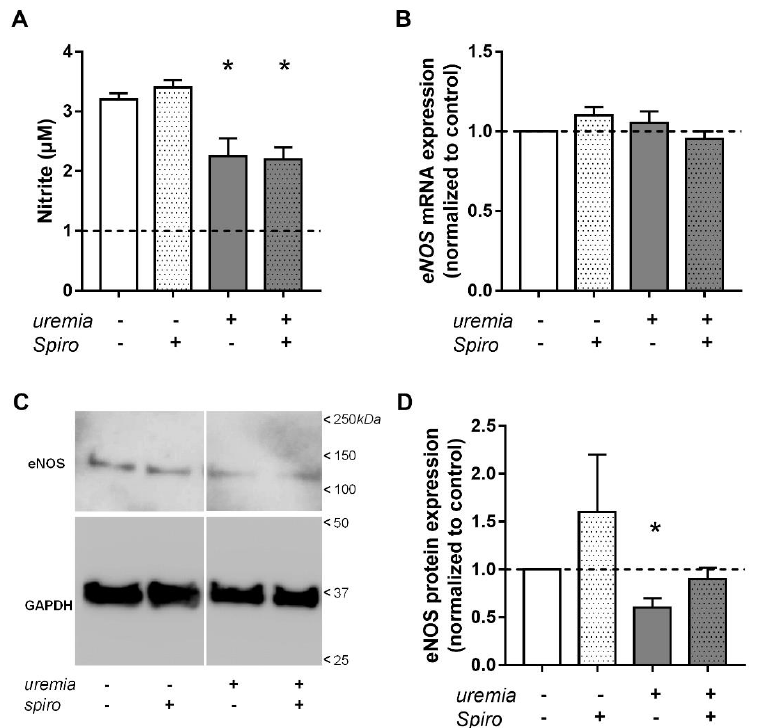
Figure 3. Uremic serum decreases NO bioavailability and eNOS protein abundance. ( A ) Nitrite accumulation in HAEC cultured for five days in control (white bars) or uremic serum (grey bars) in the presence (dotted bars) or absence of 0.1 µM spironolactone (Spiro). Bars represent average ± SE (N = 3, *, p < 0.05 vs. control). ( B ) eNOS mRNA abundance was analyzed by qPCR. Bars represent average fold-change compared to control ± SE (N = 3, no significant change was detected). ( C ) Representative Western blot images obtained using anti-eNOS or anti-GAPDH antibodies. Arrows indicate the relative of molecular mass markers (values in kDa). ( D ) Relative abundance of eNOS protein in HAEC treated as indicated. Bars represent average fold-change compared to control ± SE (N = 3, *, p < 0.05 vs. control). Table 1. Correlations of glycocalyx properties with clinical variables and serum concentrations of gut-derived uremic toxins. Correlations of glycocalyx properties with clinical data of children with CKD. Variables showing correlations with statistical significance ( bold ). Abbreviations: SDS = standard deviation score, cIMT = carotid intima-media thickness, PWV = pulse wave velocity, IS = indoxyl-sulfate, PCS = p-cresyl-sulfate, Angpt = Angiopoietin, eGC = endothelial glycocalyx.